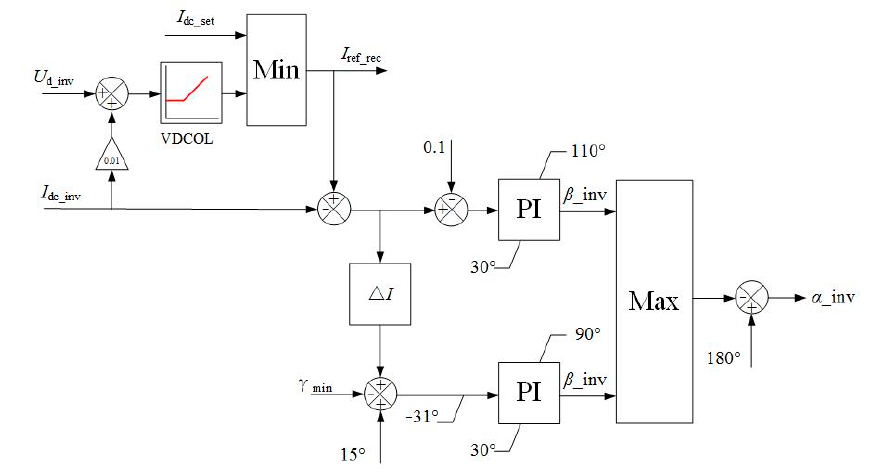
Figure 6. Inverter LCC control strategy.